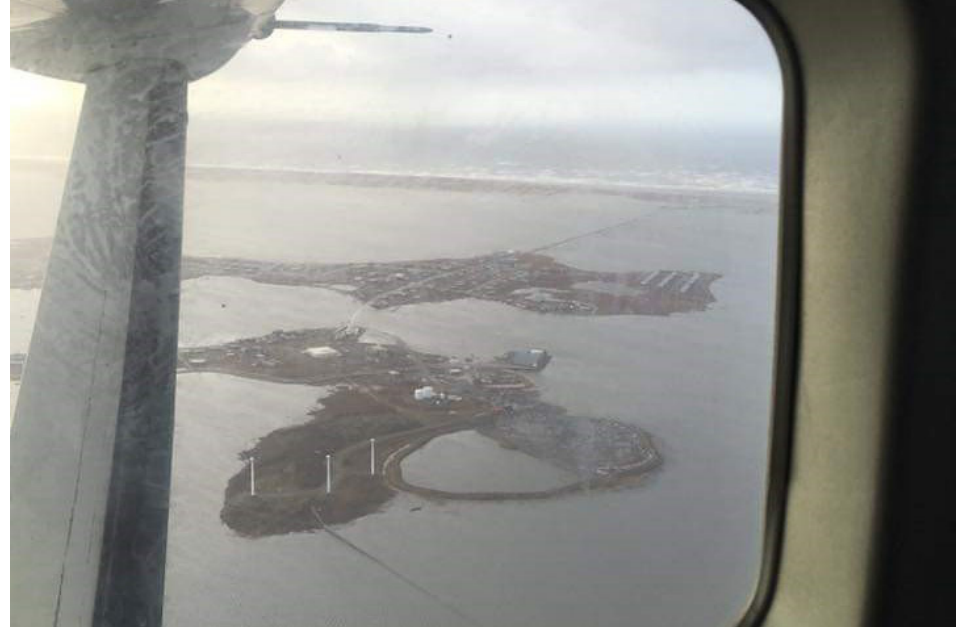
Figure 5. Hooper Bay flooding (photo by William Naneng, 2016, used with permission).